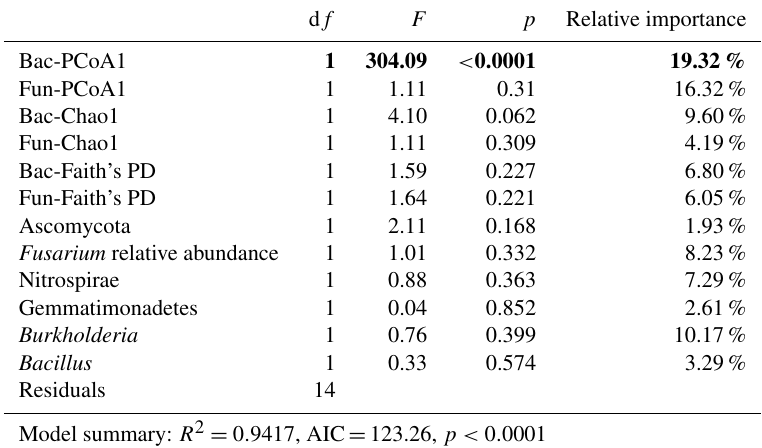
Table 3. Linear models (LMs) for the relationships of microbial indicators with disease incidence and the relative importance of each indicator. p was the result from ANOVAs. The bold values represent p values lower than 0.05 from the ANOVA results. d f F